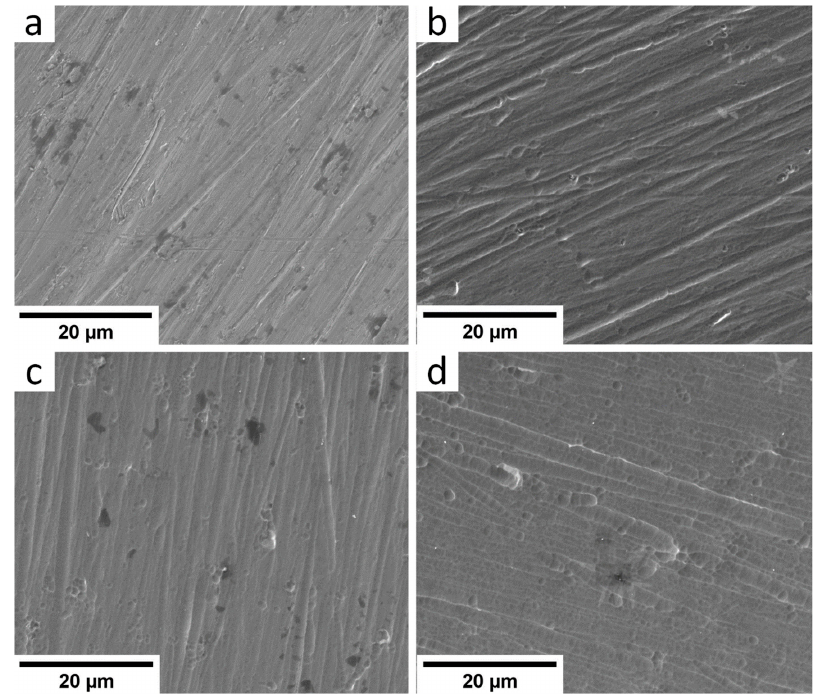
Figure 3. SEM images of a-C:H:SiO x -coated Ti-6Al-4V alloy surface before in vitro biodegradation in 0.9% NaCl solution: ( a ) uncoated, ( b ) 0.5 µm thick film, ( c ) 1.5 µm thick film, ( d ) 3 µm thick film.